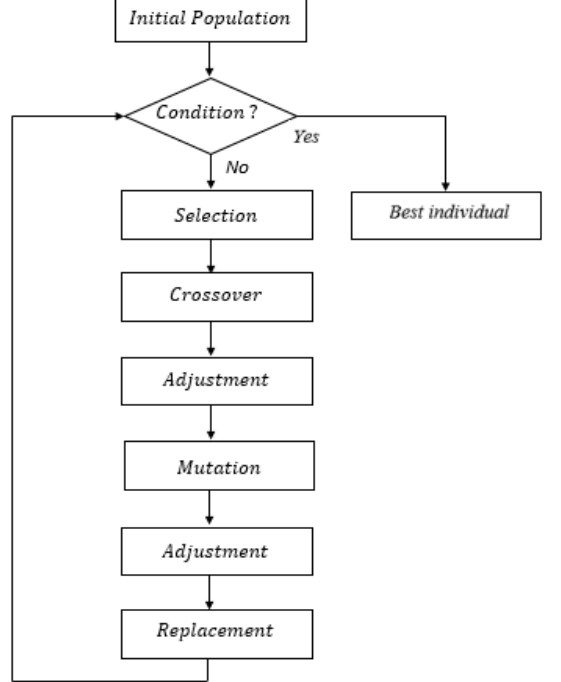
Figure 8. The steps of our genetic algorithm.